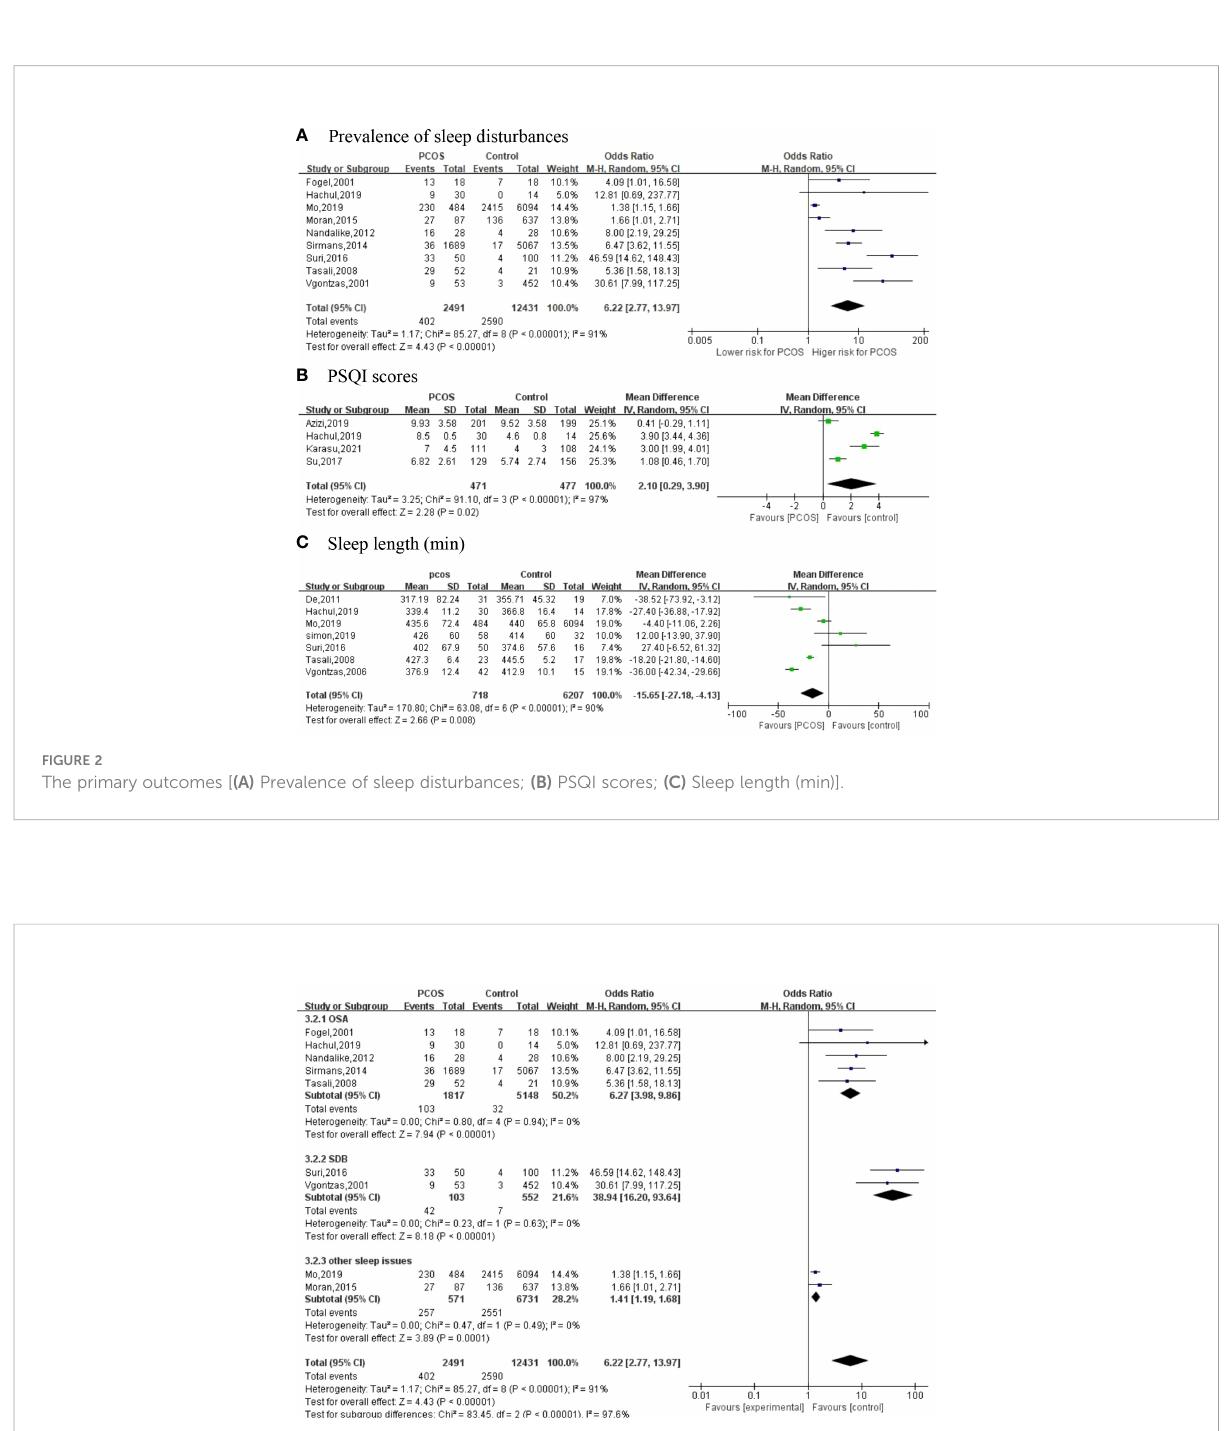
FIGURE 3 Subgroup analysis of sleep disturbances.